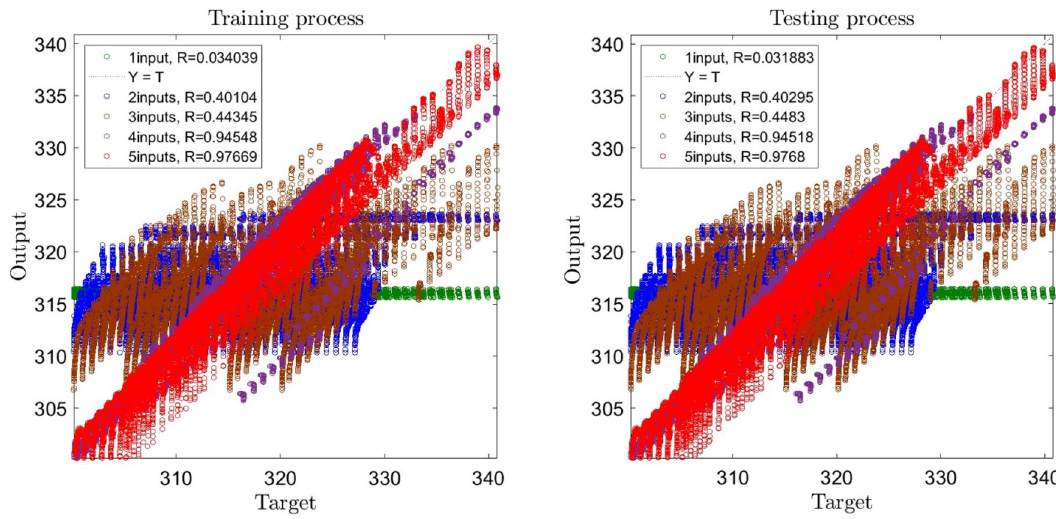
Figure 4. Learning process with changes in number of inputs from one to five.